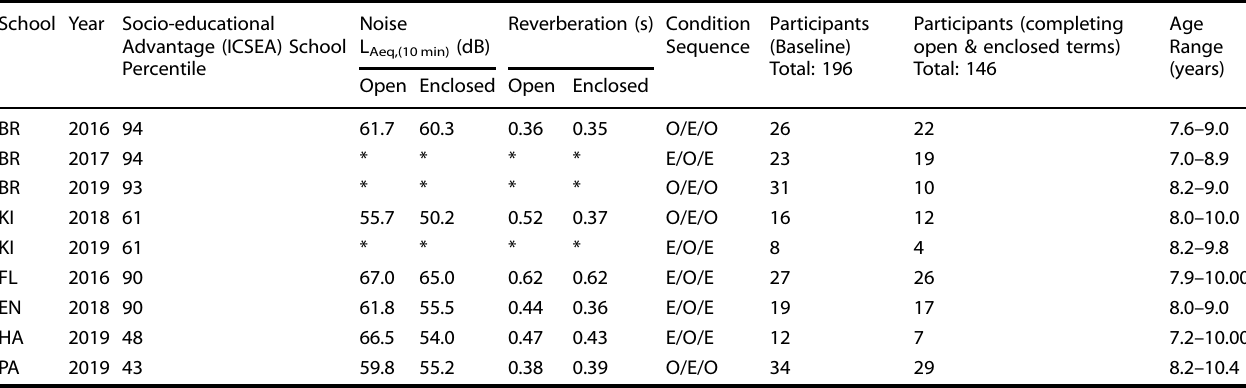
Table 2. Site and study participation details for each of the collaborating schools. School Year Socio-educational Advantage (ICSEA) School